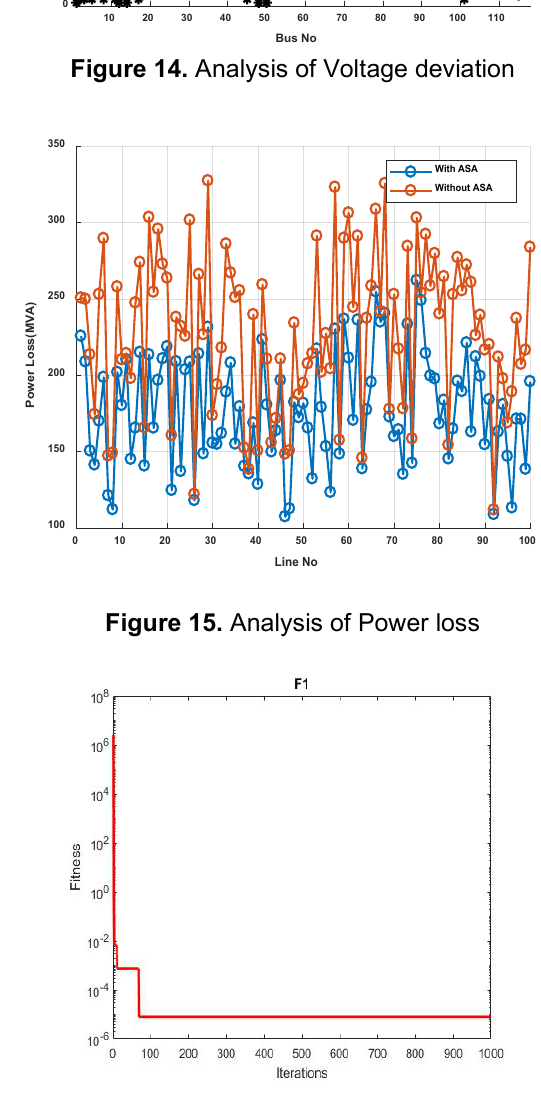
Figure 16. Analysis of Fitness